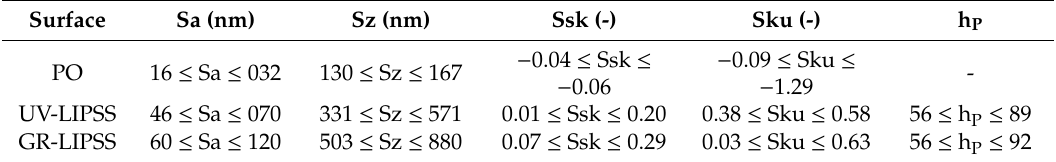
Table 3. Surface characteristics of polished surface (PO) and textured surfaces.